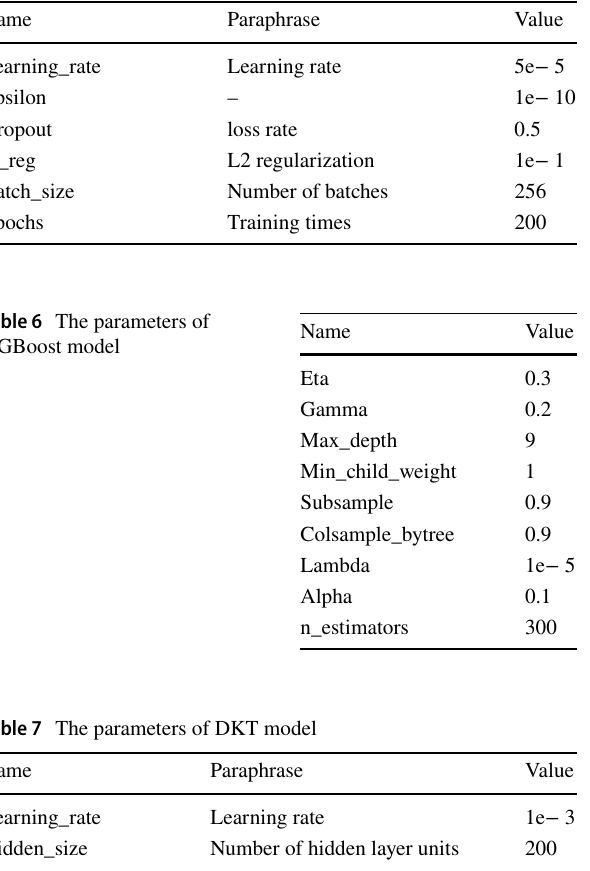
Table 5 The parameters of autoint model